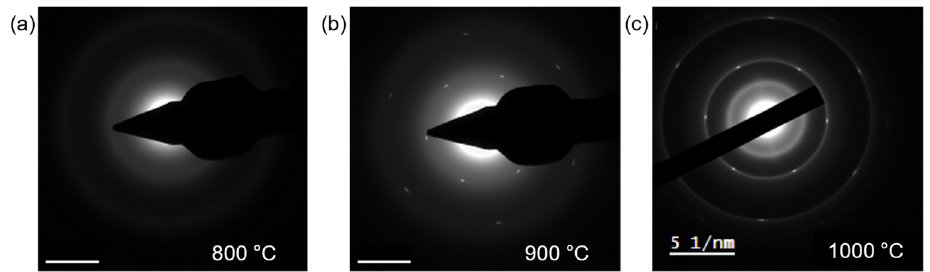
Figure 3. Relationship between growth temperature and crystallinity. ( a – c ) SAED patterns of the h-BN films synthesized at different temperatures, ( a ) 800 °C, ( b ) 900 °C, and ( c ) 1000 °C, respectively. Scale bars: 5 1/nm.